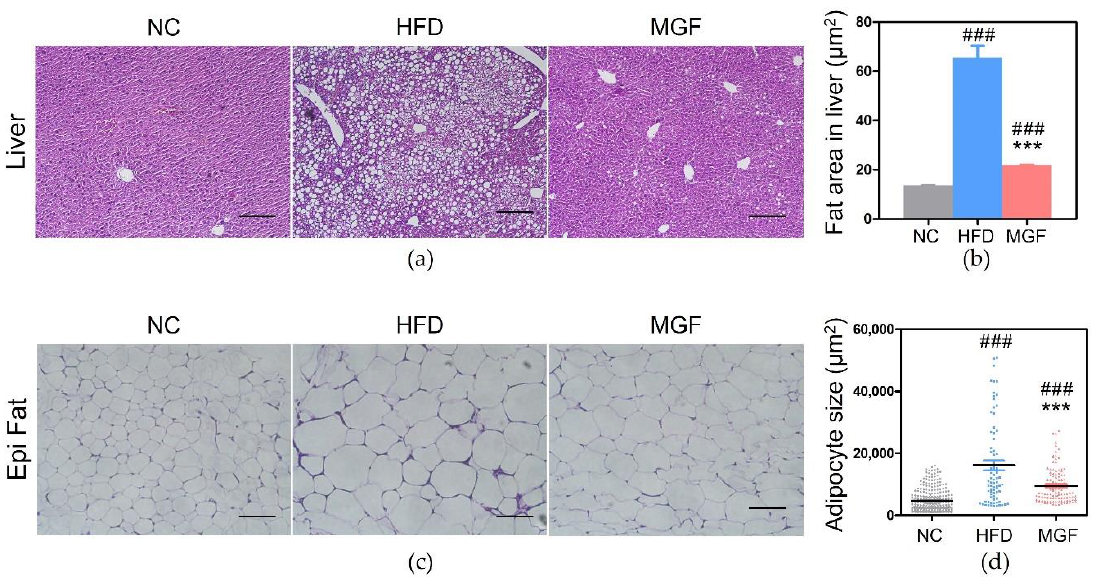
Figure 8. Histological changes in liver and epididymal fat tissues. ( a ) Histological images of the liver. ( b ) Fatty area in the liver. ( c ) Histological images of epididymal fat. ( d ) Adipocyte size. Data are expressed as mean ± standard error of mean. Bar indicates 100 µm. ### p < 0.001 indicates the results of comparison with the NC group, and *** p < 0.001 indicates the results of comparison with the HFD group. NC, normal chow; HFD, high-fat diet; MGF, HFD + MGF 150 mg/kg/day; MGF, mangiferin.